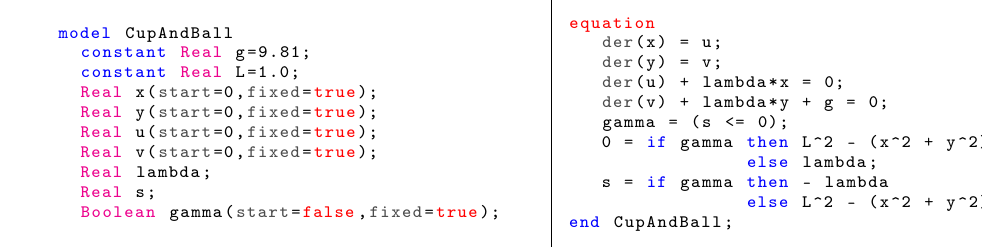
Figure 23. Modelica code for the Cup-and-Ball.